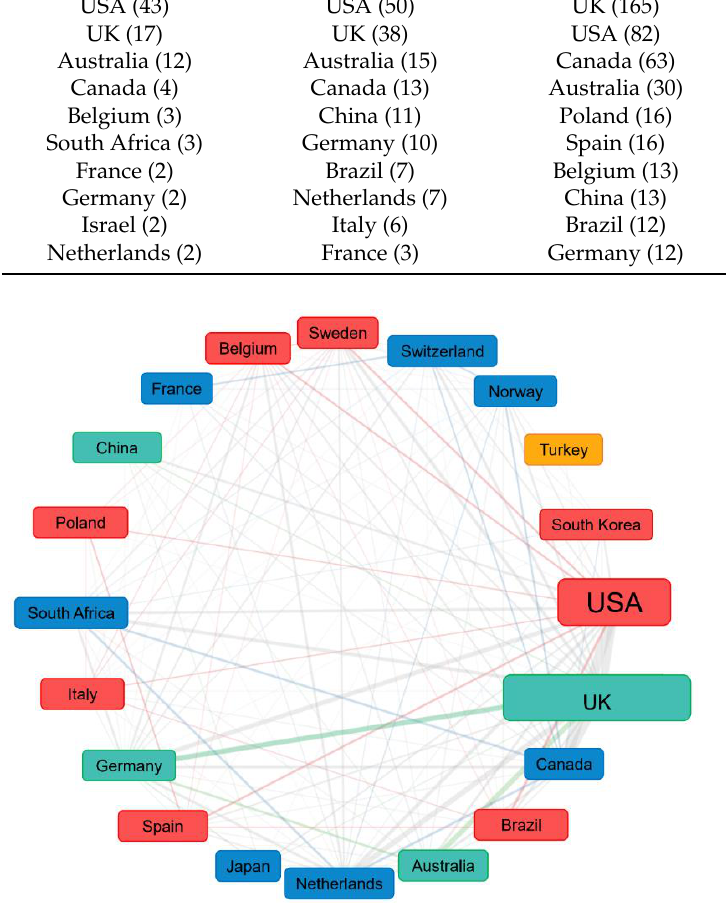
Figure 4. International collaborations on adapted sport research.